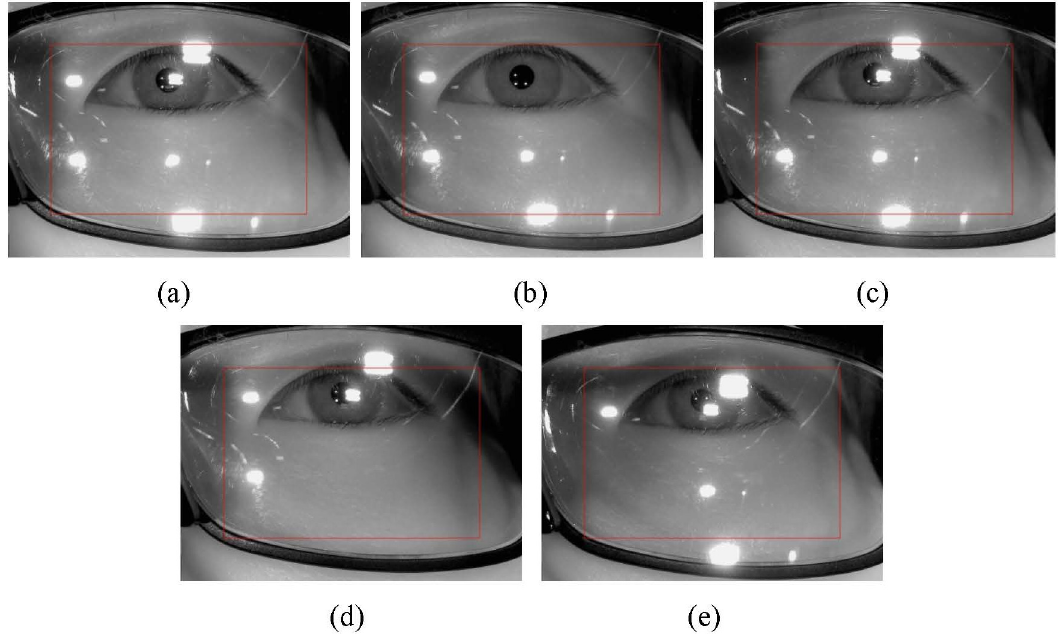
Figure 5. Examples of reflections as the illuminators are turned on and off in sequence ( a ) All four of the illuminators are on; ( b ) Only the upper-left illuminator (the 1st illuminator) is off; ( c ) Only the upper-right illuminator (the 2nd illuminator) is off; ( d ) Only the lower-left illuminator (the 3rd illuminator) is off; ( e ) Only the lower-right illuminator (the 4th illuminator) is